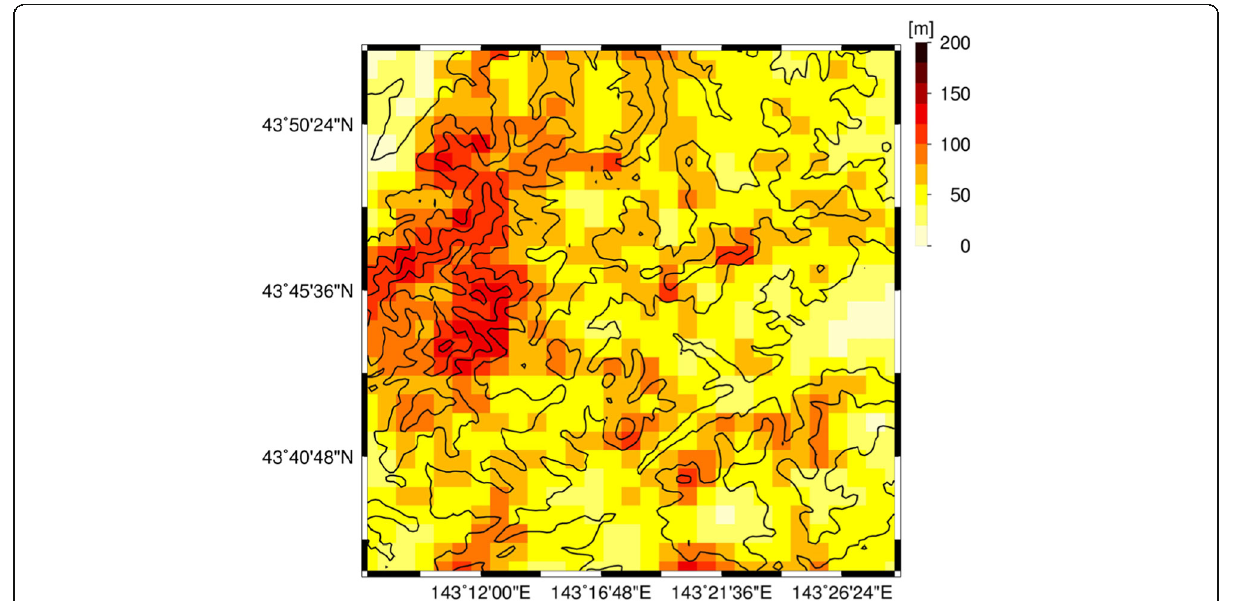
Fig. 8. The standard deviation of subgrid-scale orography. The spatial distribution of the standard deviation of the subgrid-scale orography computed in a 1 km by 1 km area from the model terrain at the 200 m grid spacing, for the area B (see Fig. 4f) as an